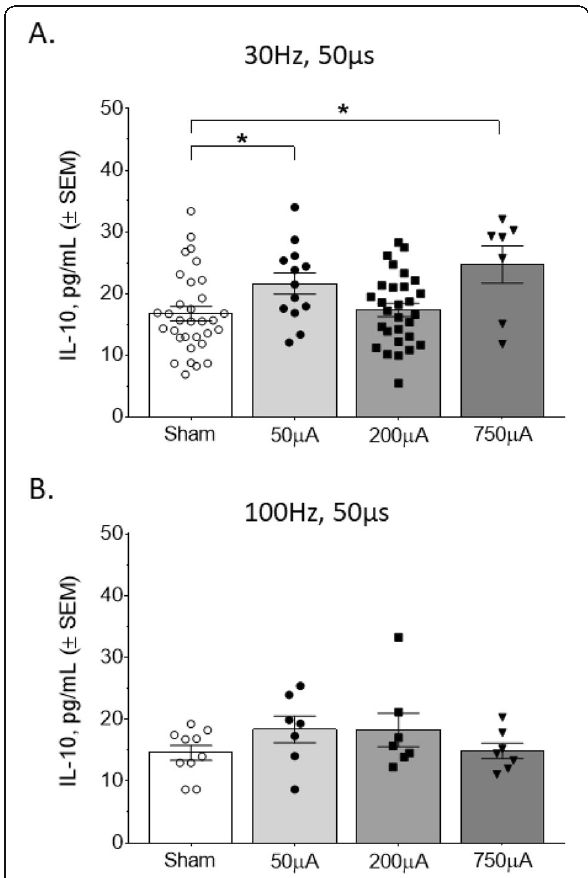
Fig. 4 Serum IL-10 is increased by select parameters of electrical stimulation with 50 μ s pulse width. a Stimulation for 50 μ s at 30 Hz produced significant increases, compared to the sham group, in IL- 10 for both 50 μ A and 750 μ A pulse amplitudes. b No changes in serum IL-10 were observed for 100 Hz stimulation across the four pulse amplitudes. Data is represented as individual mouse data points with mean ± SEM. n = 7 – 33 per group, *, P < 0.05